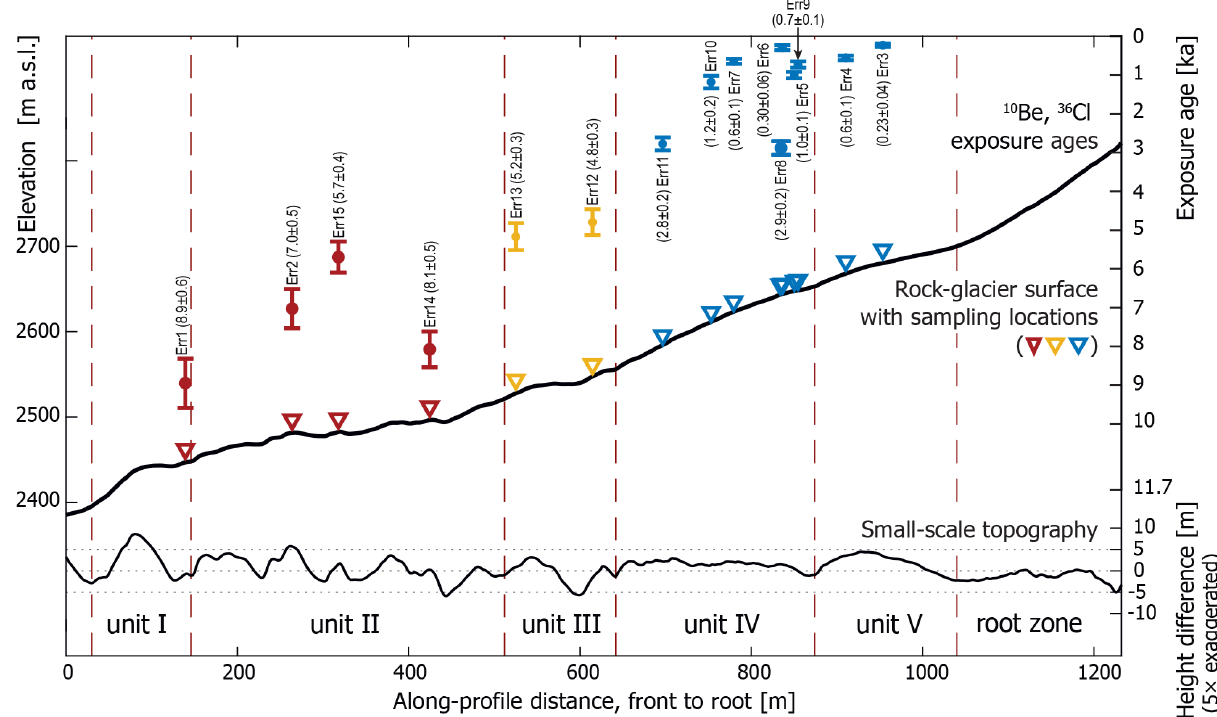
Figure 7. Longitudinal section of rock glacier surface along the profile line shown in Fig. 4 showing exposure ages (in ka; uncertainties are 1 σ external errors), sample location (triangles), surface elevation, small-scale topography, and morphological units (separated by dashed red lines). Note the stratigraphically directed time axis to emphasize the general anti-correlation of the exposure ages with altitude. Exposure ages and sampling location are projected perpendicular onto the longitudinal profile, not along (unknown) surface isochrons. The small-scale topography is a high-pass-filtered topography computed by subtracting a 100m running mean from the altitude at each